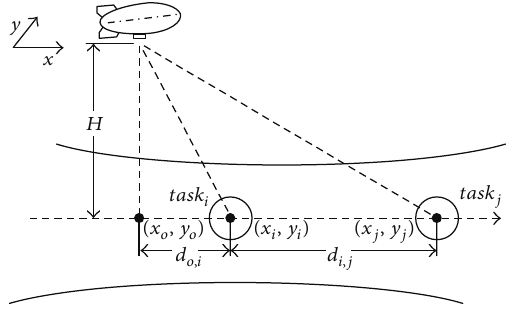
Figure 1: The cruising of high-altitude airship.